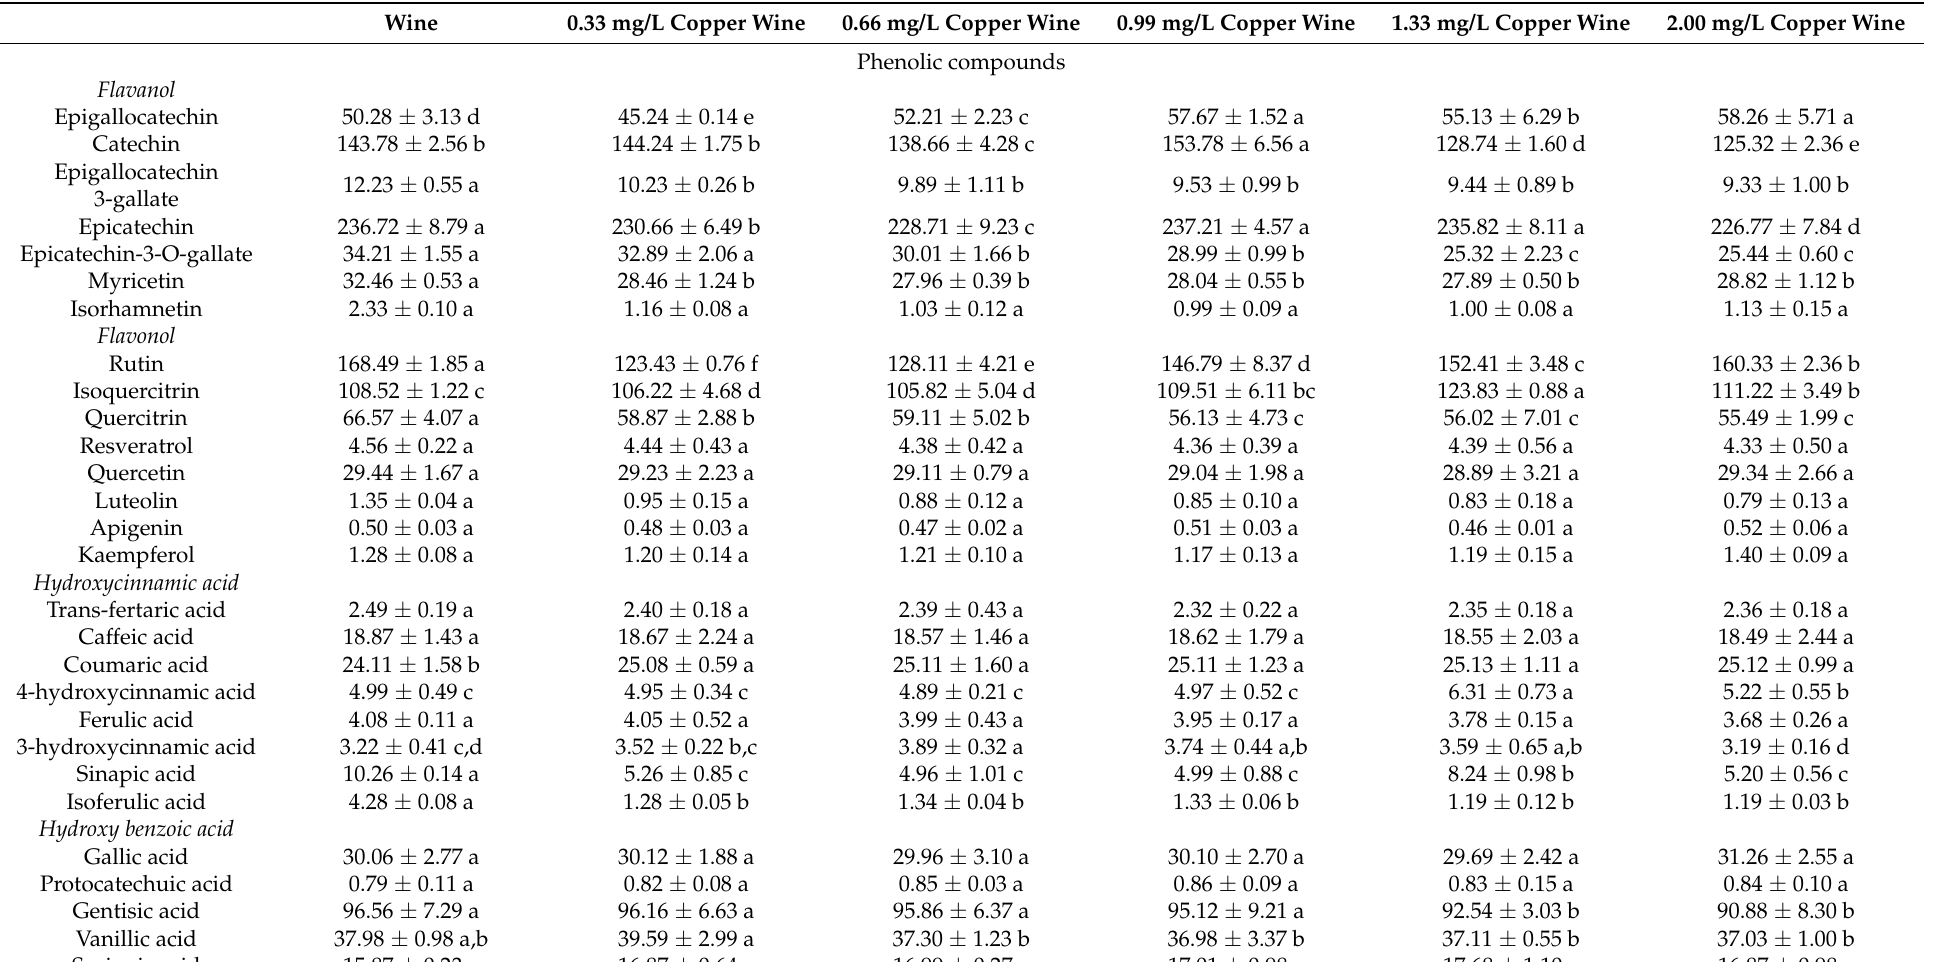
Table 1. The phenolic compounds and organic acids of intragastric